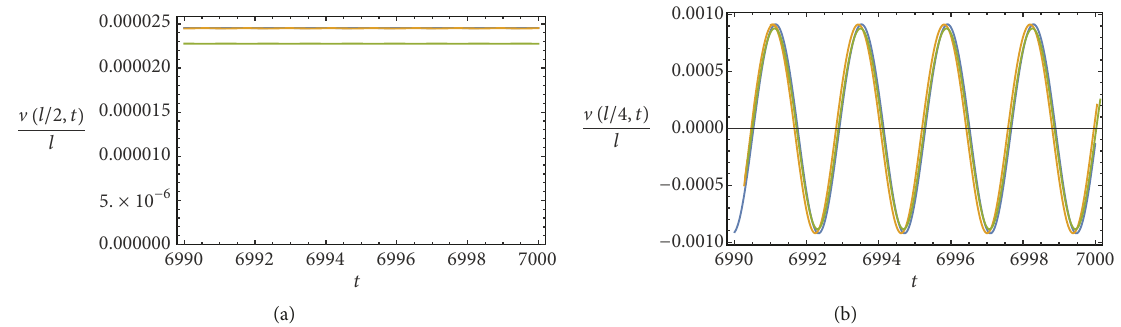
Figure 8: Case-study 2: reconstituted time evolution of the displacement V (𝑠,𝑡) for 𝑈 2 /𝑈 𝑐 = 0.09 at (a) half-span and (b) quarter-span (green line: multiple scale method; blue line: Galerkin method; orange line: finite difference method).